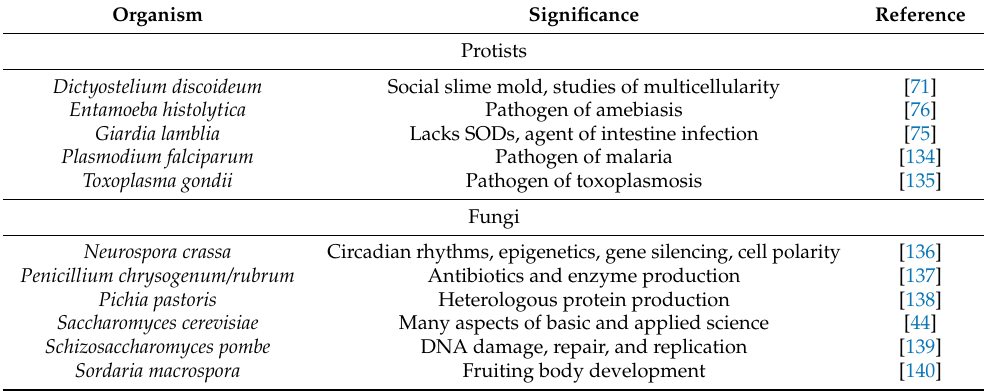
Table 1. Selected literature for relevant eukaryotic microorganisms not covered in this